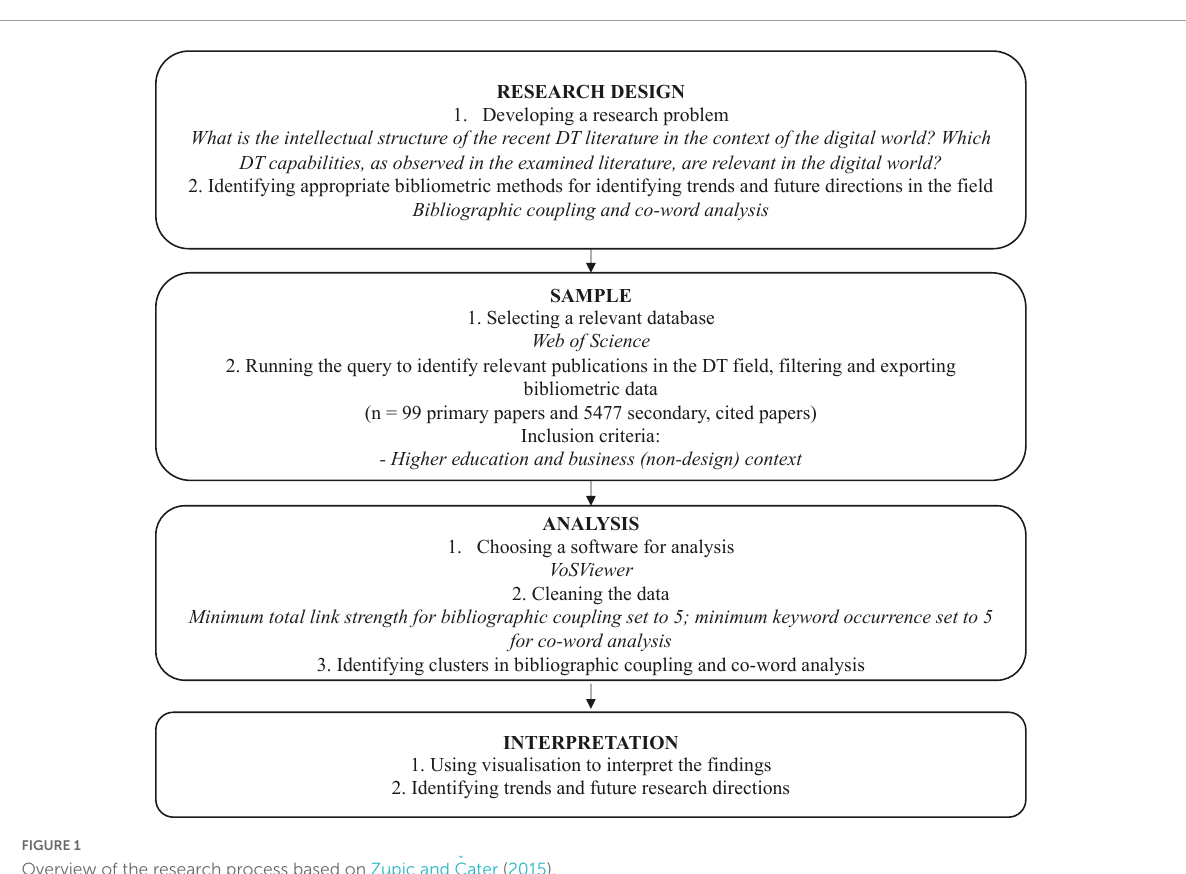
FIGURE1 Overview of the research process based on Zupic and ˇCater (2015).